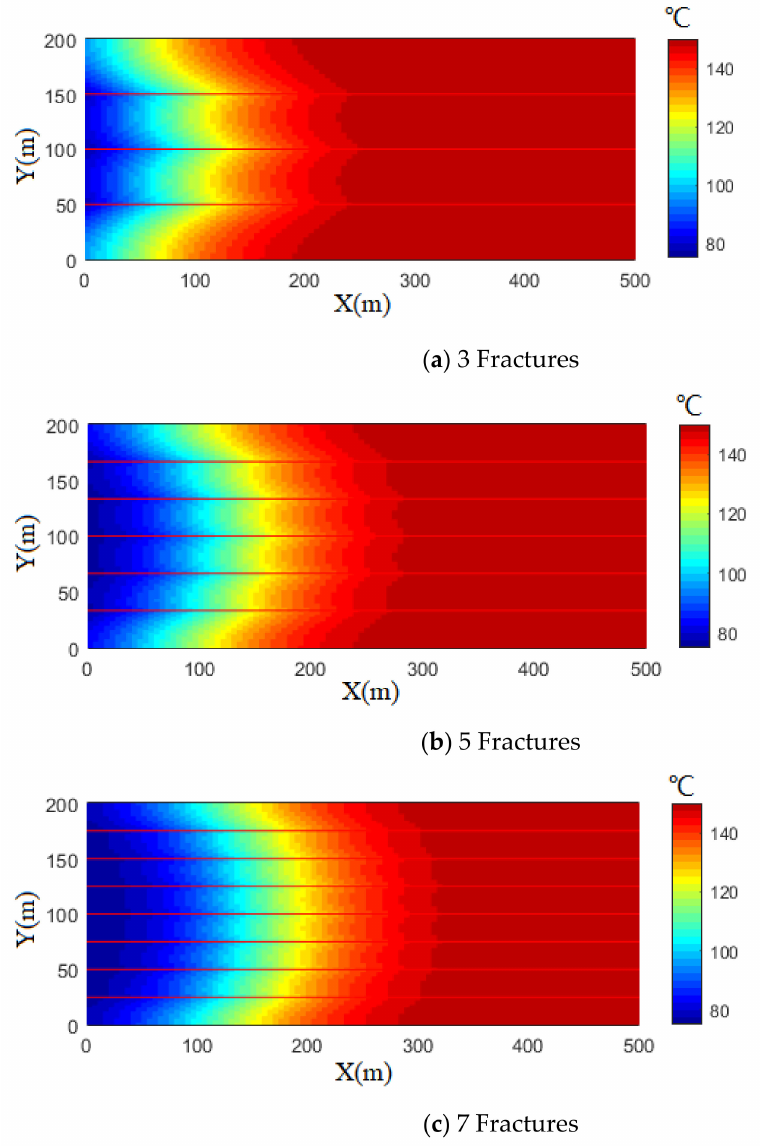
Figure 7. Thermal front for different fracture numbers. Compared with ( a – c ), the thermal front in the matrix and fractures is arriving almost at the same time when the number of fractures